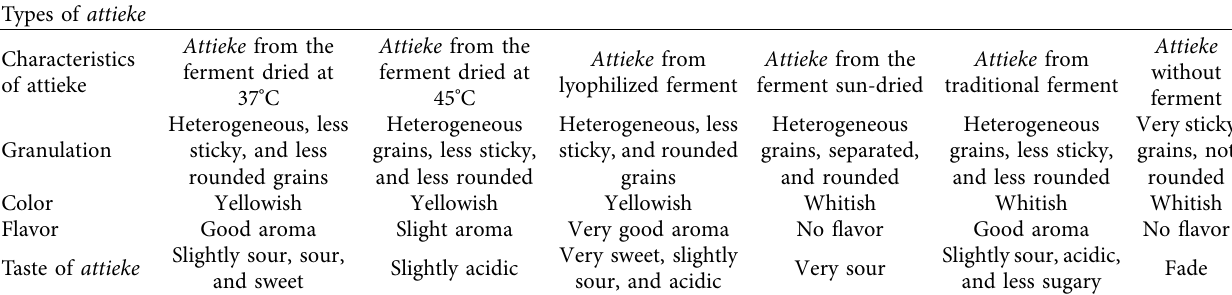
Table 3: Descriptive characteristics of attieke produced with the different dried